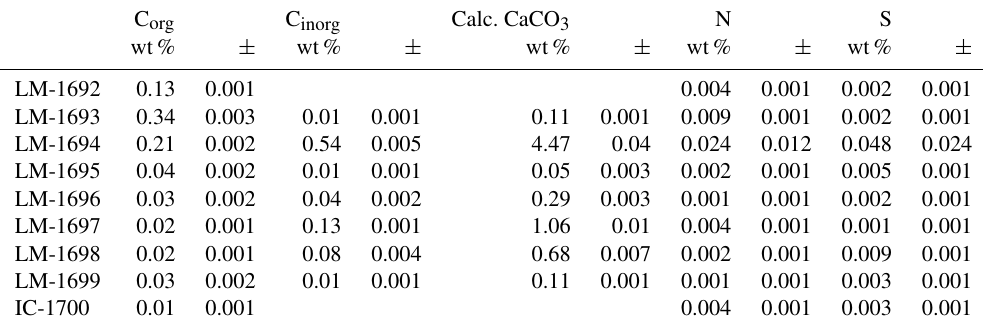
Table 1. Geochemical bulk data (C, N, S). C org C inorg Calc. CaCO 3 N S wt% ± wt% ± wt% ± ±